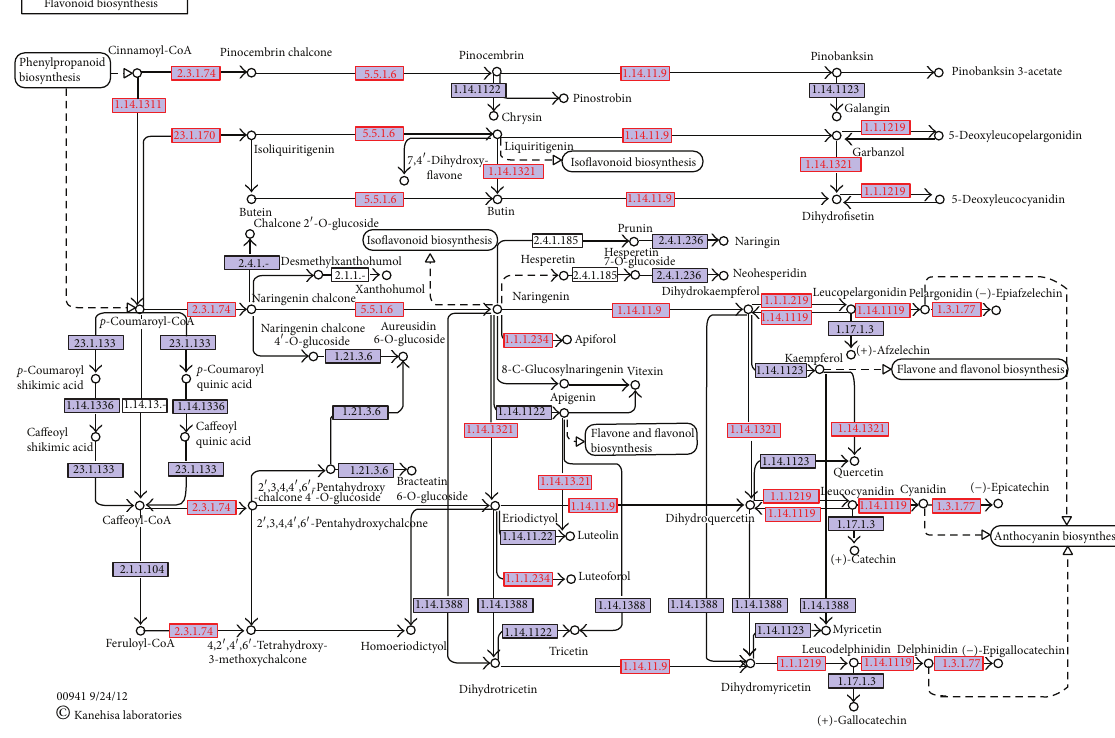
Figure 5: Genes encoding enzyme commission (ECs) in flavonoid biosynthesis pathway were upregulated (red) in the transcriptome of resistant crape myrtle genotype (“Natchez,” NAT) compared to susceptible crape myrtle genotype (“Carolina Beauty,” CAB)